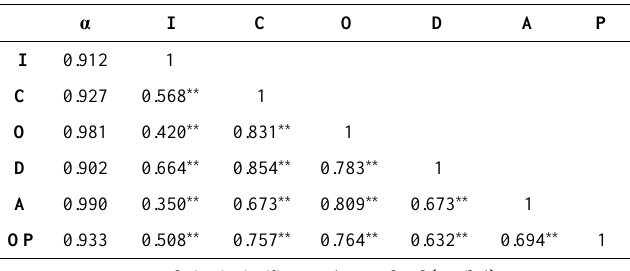
Table 5. Correlation matrix for the private sector